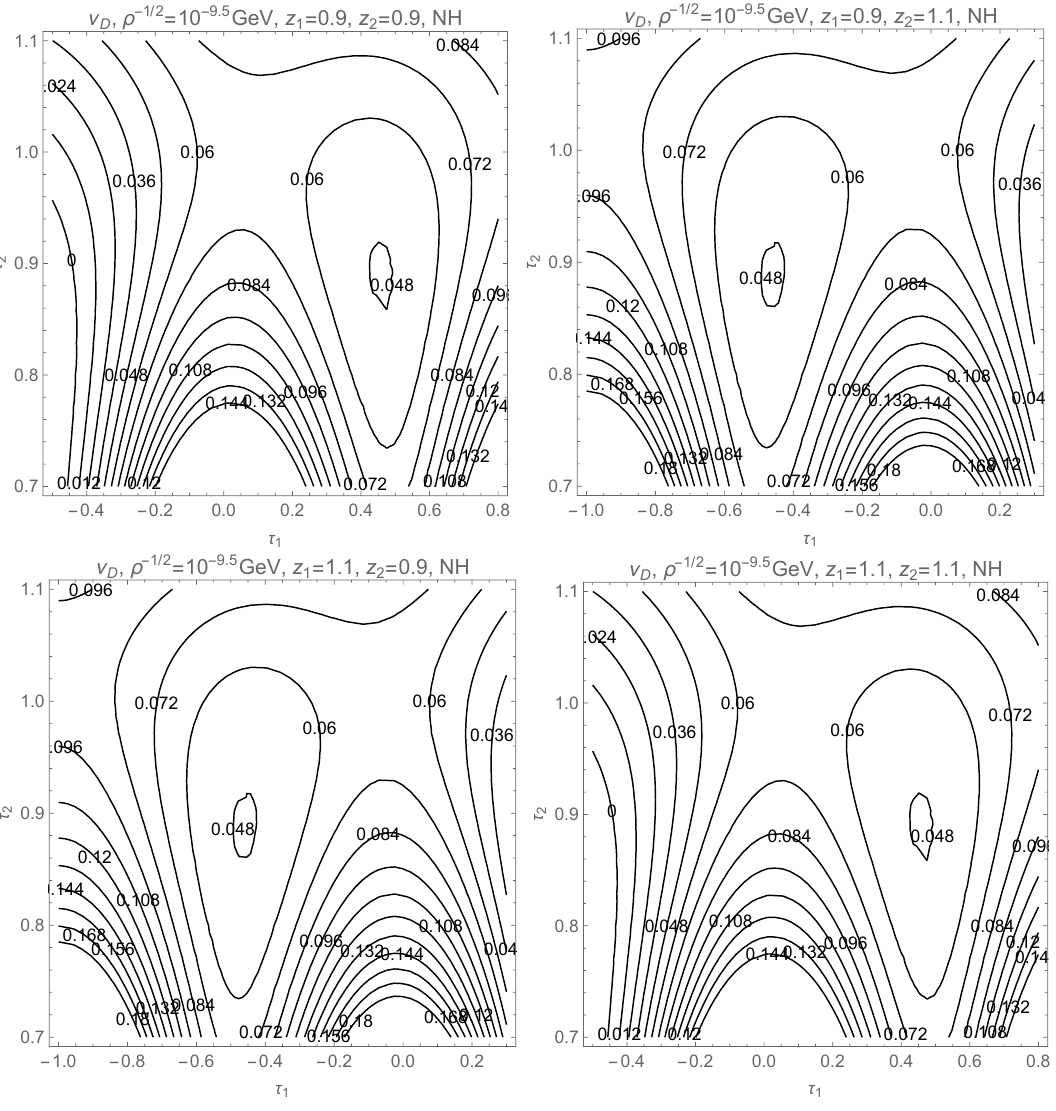
Figure 21 . The minimum around (cid:28) = e i(cid:25)= 3 survives as a local minimum if the boundary condition is close to